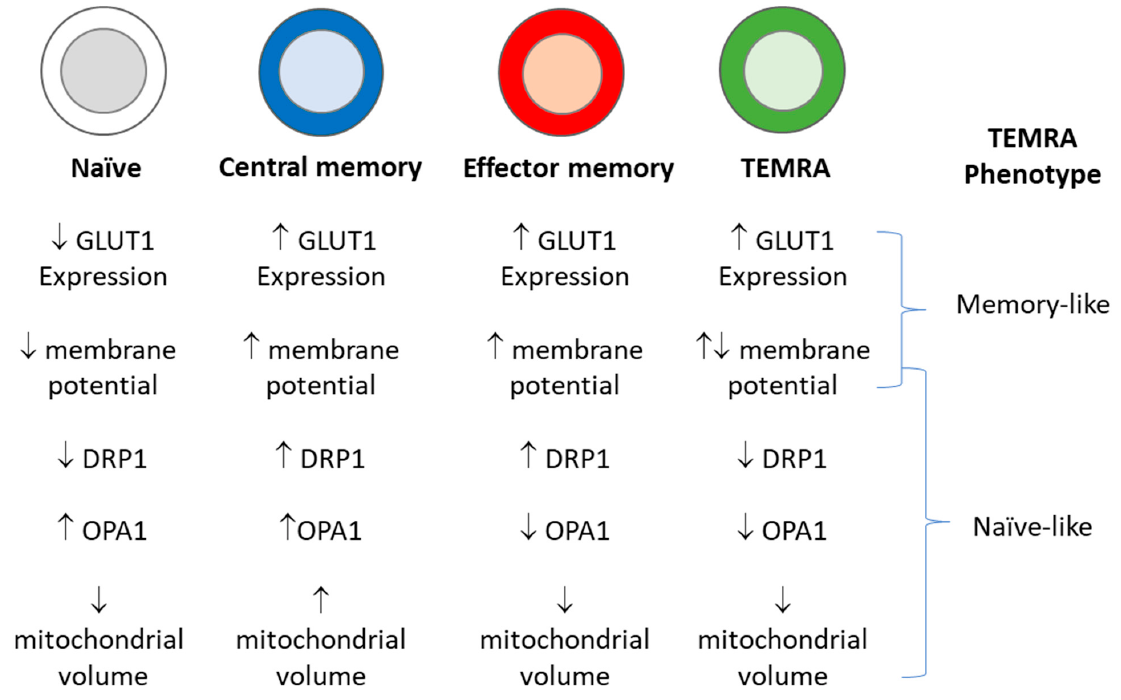
Figure 5. Summary of mitochondrial findings in CD4+ naïve and memory T cells, including terminal effector memory T cells re-expressing CD45RA (TEMRA) cells. Arrows indicate an increase or decrease in the respective parameter.